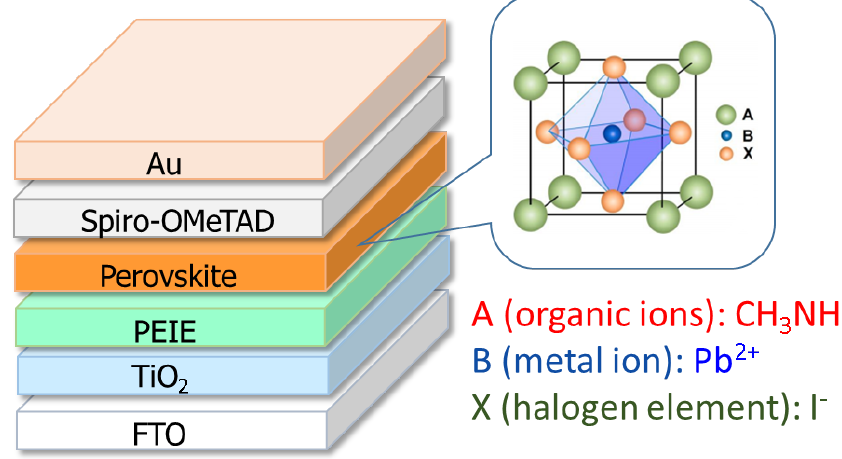
Figure 1. Typical device structure of the PePS under study. Tested device structures are FTO/TiO 2 /without and with PEIE/one- and two-step perovskite/Spiro-OMeTAD/Au. The surface morphologies were investigated using a field emission scanning electron microscope (FE-SEM, JEOL 6700F). The photo-sensing characteristics of the PePSs were measured using a semiconductor parameter analyzer (HP4145B) and solar simulator (Yamashita Denso, YSS E40) under Air Mass (AM) 1.5, 100 mW/cm 2 . Photocurrent density J p and dark-current density J d are evaluated at the voltage of − 0.2 V. 3. Results and Discussions Figure 2 shows the FE-SEM observation on the TiO 2 layer fabricated by the CBD method [33]. The surface morphology was comparatively flat and grain size was observed between 0.1 and 1 μ m. In our previous EB evaporation method [36], a flat surface was also observed; however, there are many raised portions with shadow regions on the TiO 2 sur- face. In the CBD method, there are few raised portions and many small structures of sev- eral 10 nm on the TiO 2 surface.